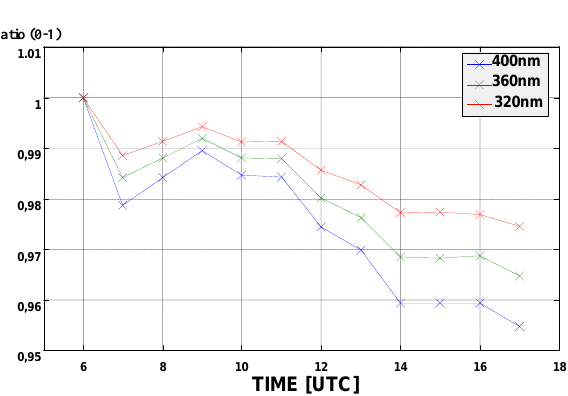
Fig. 8. The ratios (0–1) of modeled irradiances using maximum measured albedo A max for 22 April, and measured albedo A for the same